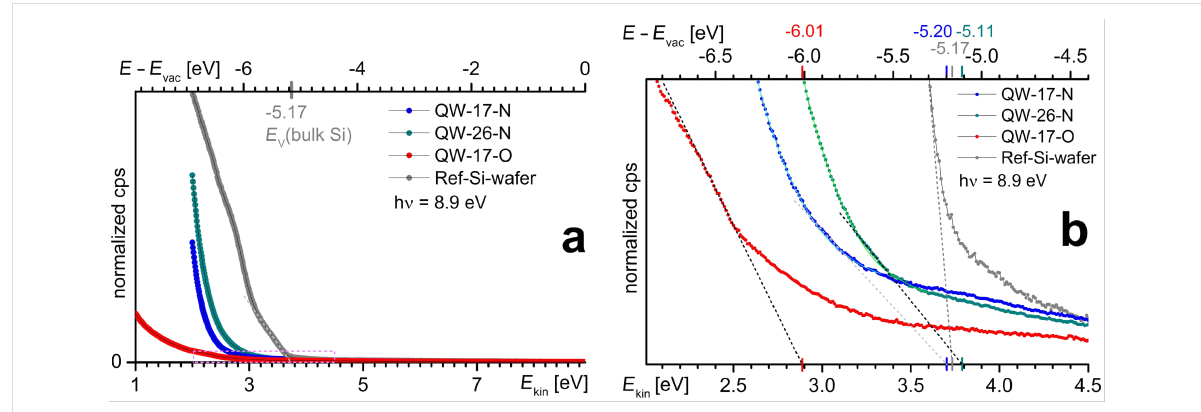
Figure 5: Experimental evidence of HOMO Δ E by synchrotron UPS: (a) scans of NWell samples and a hydrogen-terminated (111) Si wafer as a refer- ence for the Si-NWells. The valence band edges of Si-NWells detected are located within the magenta lines and shown in (b). The bottom energy scales refer to electron kinetic energy up to UV photon energy. The top energy scale shows the energetic position of electrons relative to vacuum level with valence band edges and respective energy values as extracted from the spectra (dashed lines). The light green and cyan lines show the background fit of the amorphous Si 3 N 4 -matrix. The lower signal-to-noise ratio for Si-NWells embedded in Si 3 N 4 as compared to SiO 2 is comprehen- sively evaluated and discussed in Supporting Information File 1.